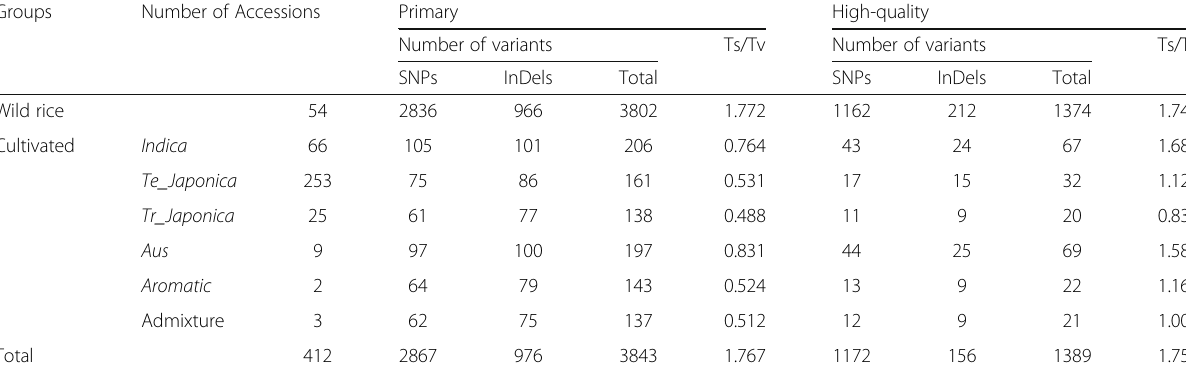
Table 1 Summary of the SNPs and InDels in chloroplast genome of 358 Asian rice and 54 wild rice Groups Number of Accessions